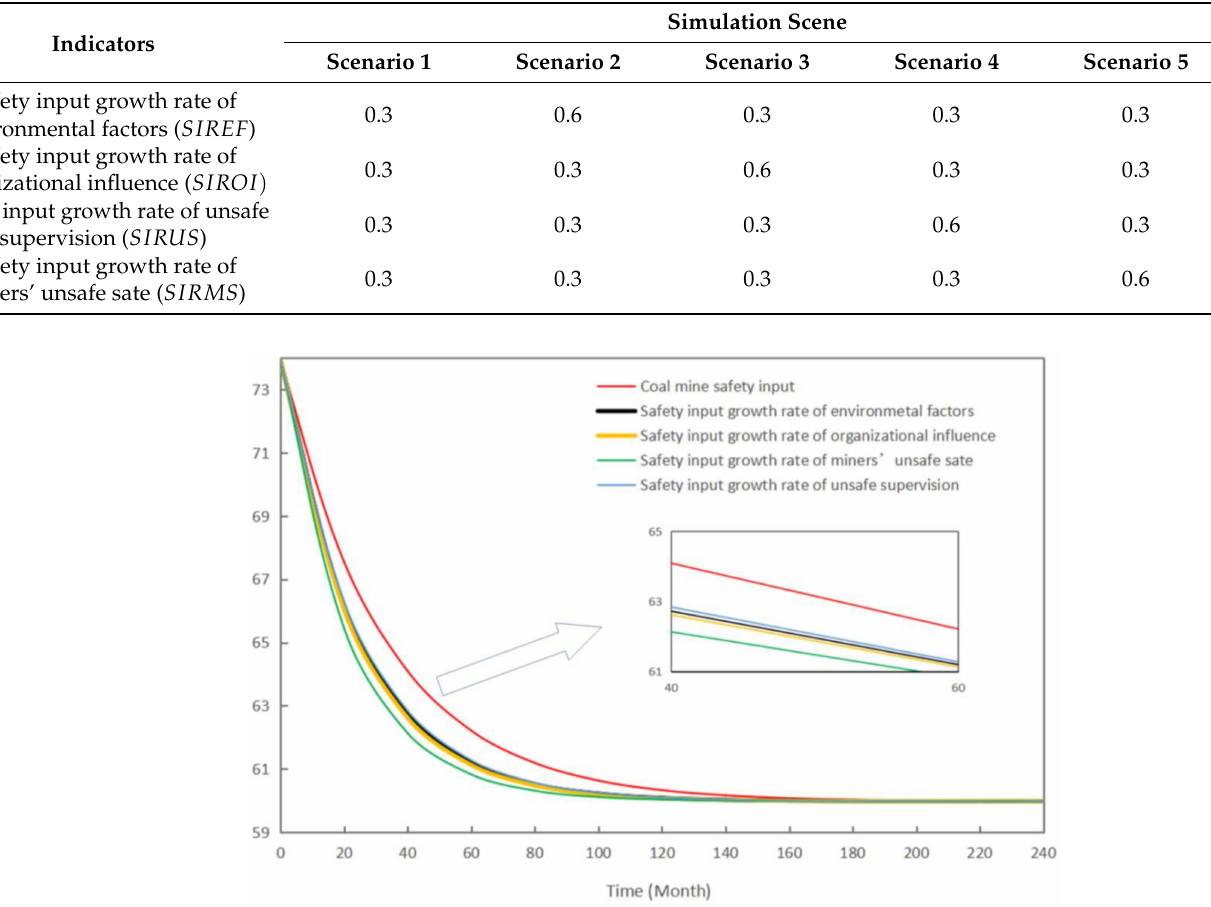
Figure 8. Dynamic influence of the increase rate of each subsystem safety input on the level of miners’ unsafe